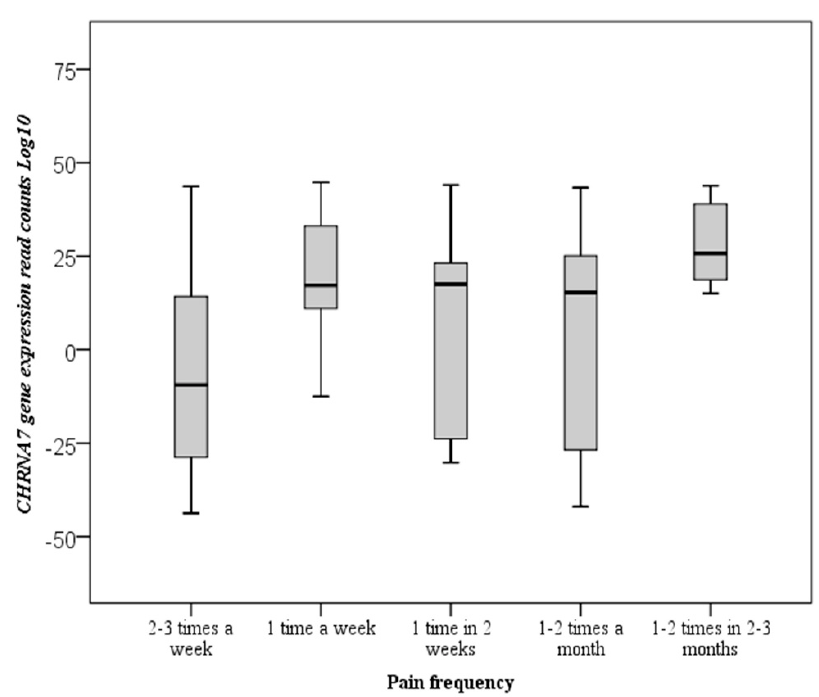
Figure 2. Boxplot of the CHRNA7 gene expression for migraine frequency according to Dunn’s multiple comparison test results. The total numbers of mRNA reads are log10 transformed.